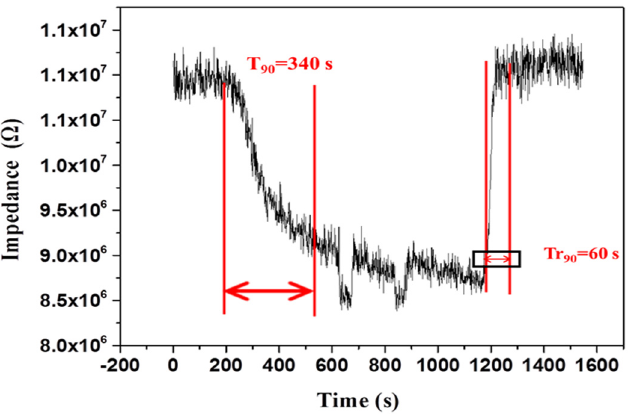
Figure 7. Response and recovery characteristics of 5 wt.% PPy/BiPO 4